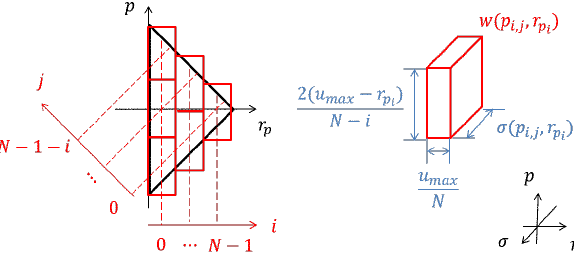
Figure 3. Discretizing the domain of integration of the play